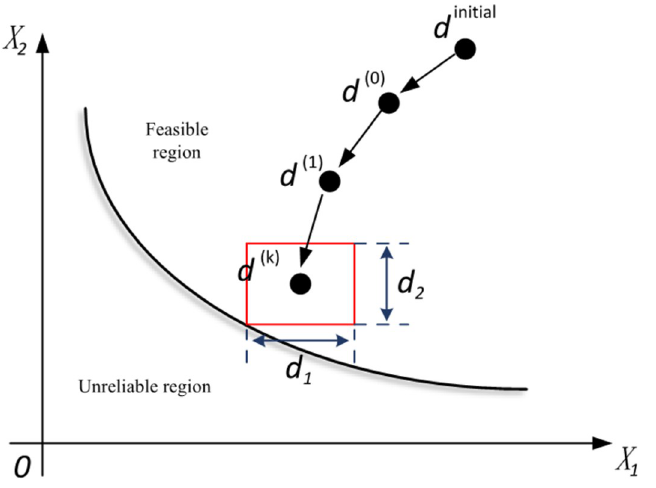
Fig 13. The interval uncertainty optimization